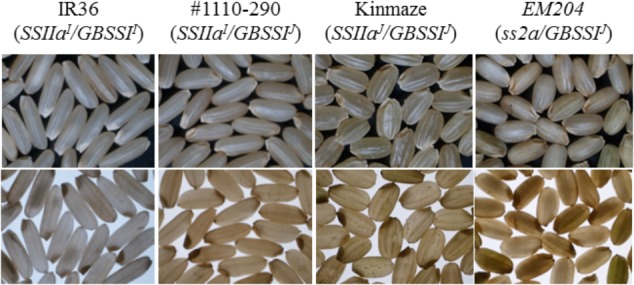
Morphology of rice grains observed using a stereo-microscope with overhead light (upper panels) and on a light box (lower panels). The parts that are chalky or opaque in the seeds appeared dark on a light box. Note that central region of some of EM204 seeds were chalky. IR36, indica rice cultivar, SSIIaI/GBSSII; #1110-290, SSIIaI/GBSSIJ; Kinmaze, japonica rice cultivar, SSIIaJ/GBSSIJ; EM204, ss2a/GBSSIJ.